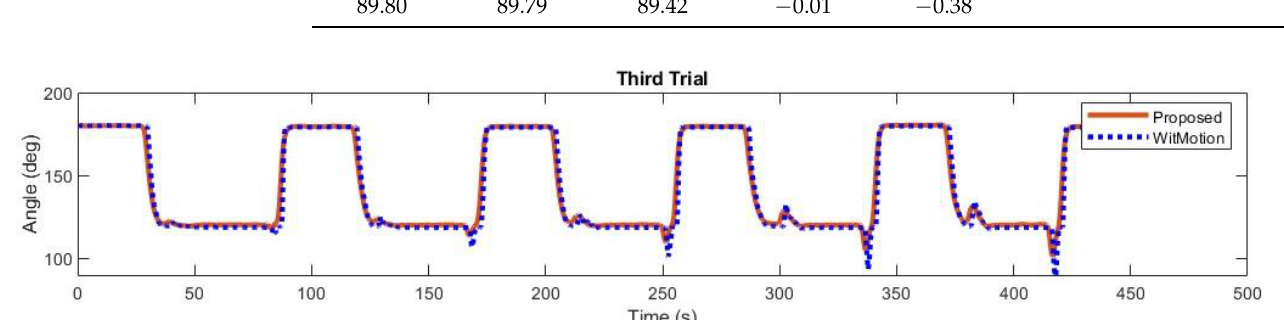
Figure 8. Measured angle using proposed algorithm (PA) and WitMotion (WM) (third trial).